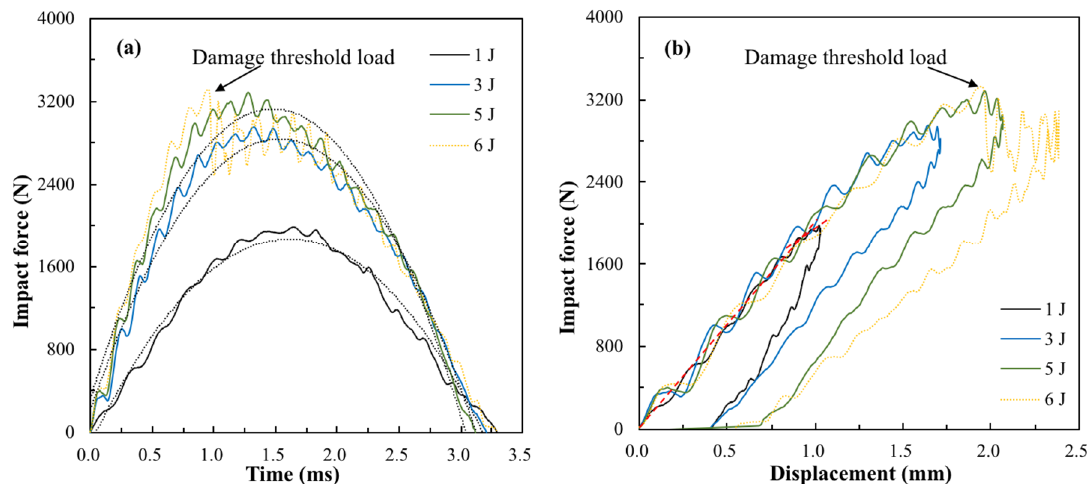
Figure 2. ( a ) Impact load–time curve and ( b ) impact load–displacement curve of flax fiber reinforced epoxy plastic (FFRP) following incident energies of 1, 3, 5, and 6